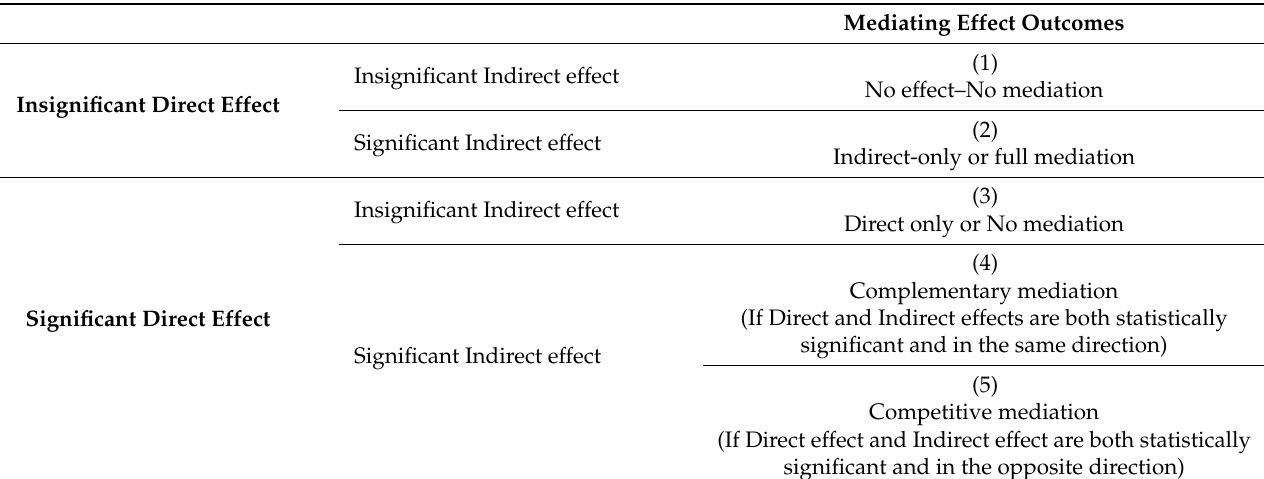
Table 8. Mediation possible outcomes.